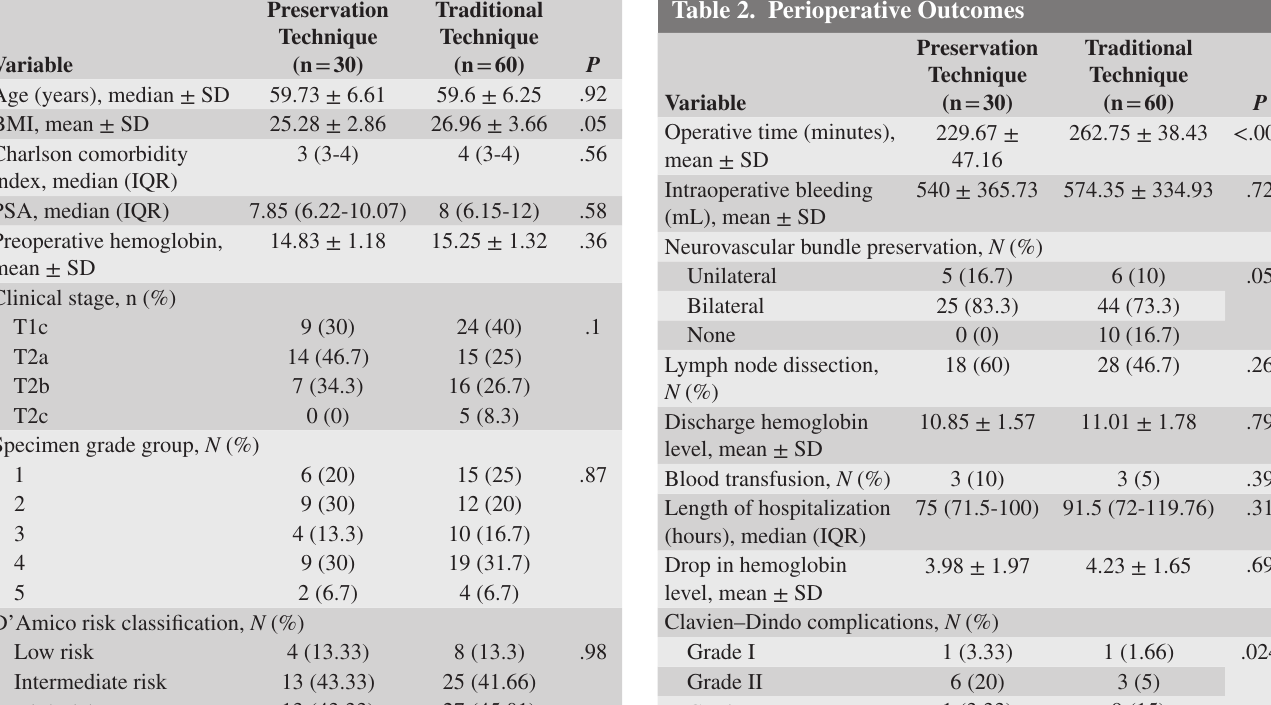
Table 1. Demographic and Preoperative Features